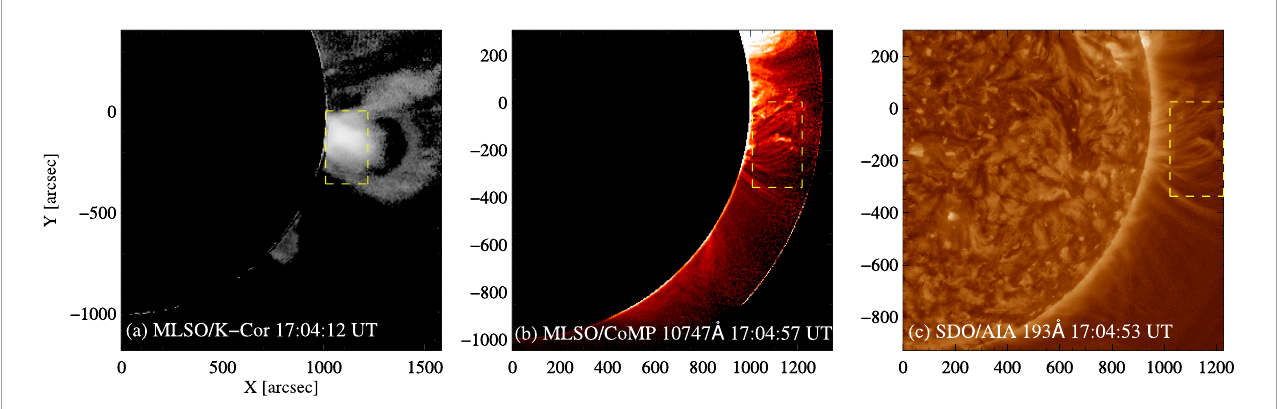
FIGURE 1 (A) 20 July 2017, CME as observed by the K-Cor. All three parts of the CME are clearly visible. The yellow rectangular box shows the ROI chosen for the analysis. (B) The CoMP 10747 Å channel enhanced intensity image. When CoMP observation started, only the core of the CME was visible in the CoMP FOV. The yellow box is the CoMP ROI aligned with the K-Cor ROI shown in Figure (A) . (C) The AIA 193 Å channel image processed using MGN to enhance the CME core structures. The yellow box is the AIA ROI aligned with the CoMP ROI shown in Figure (B) . (An animation of the evolution of the CME core in the K-Cor, CoMP 10747 Å, and AIA 193 Å channel is available in the Electronic Supplementary Material. The yellow circle in the animation represents the CoMP